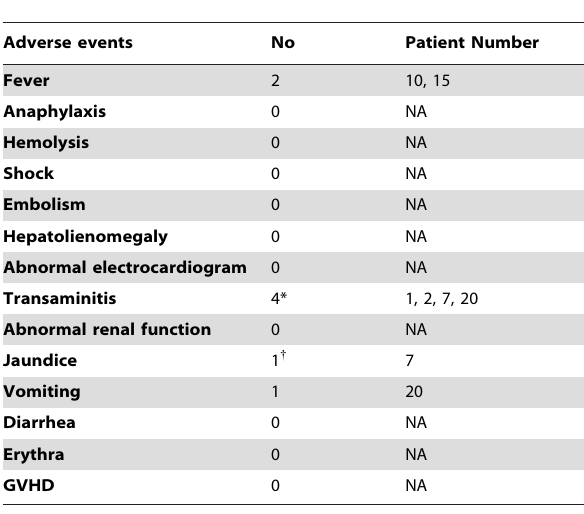
Table 3. Adverse reaction in MP-infusion